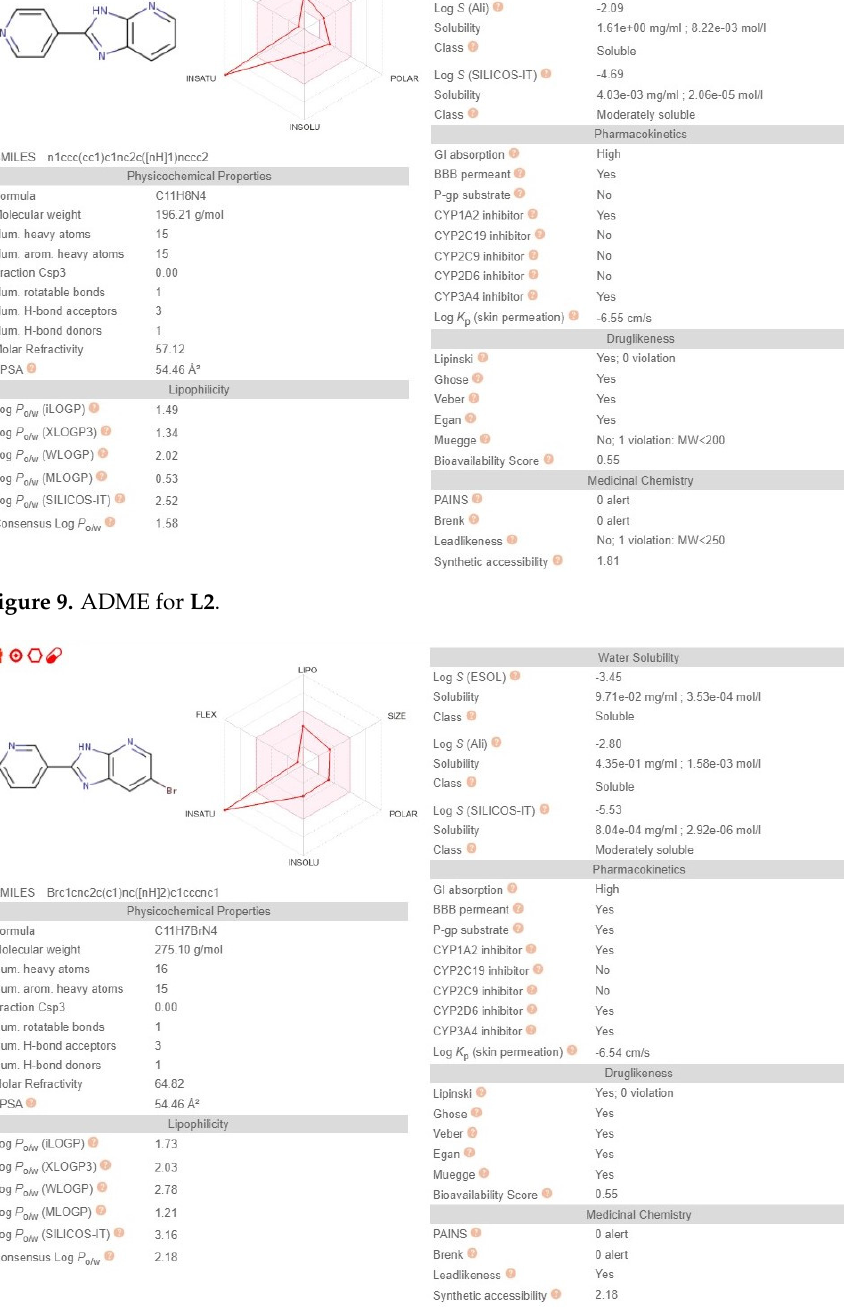
Figure 11. ADME for C1 . Lipophilicity (LIPO) for ligands was within the range 1.01 < XlogP3 < 2.03; for com- plex 3.77, polarity (POLAR) was within the range 54.56 Å2 < TPSA < 111.46 Å2, where TPSA (topological polar surface area). Ligands belong to the class of moderately soluble compounds, while the synthesized compound belongs to the class of poorly soluble com- pounds. Ligands L1 and L2 met the rules of Lipi ń ski [27], Ghose [28], Veber [29], and Egan